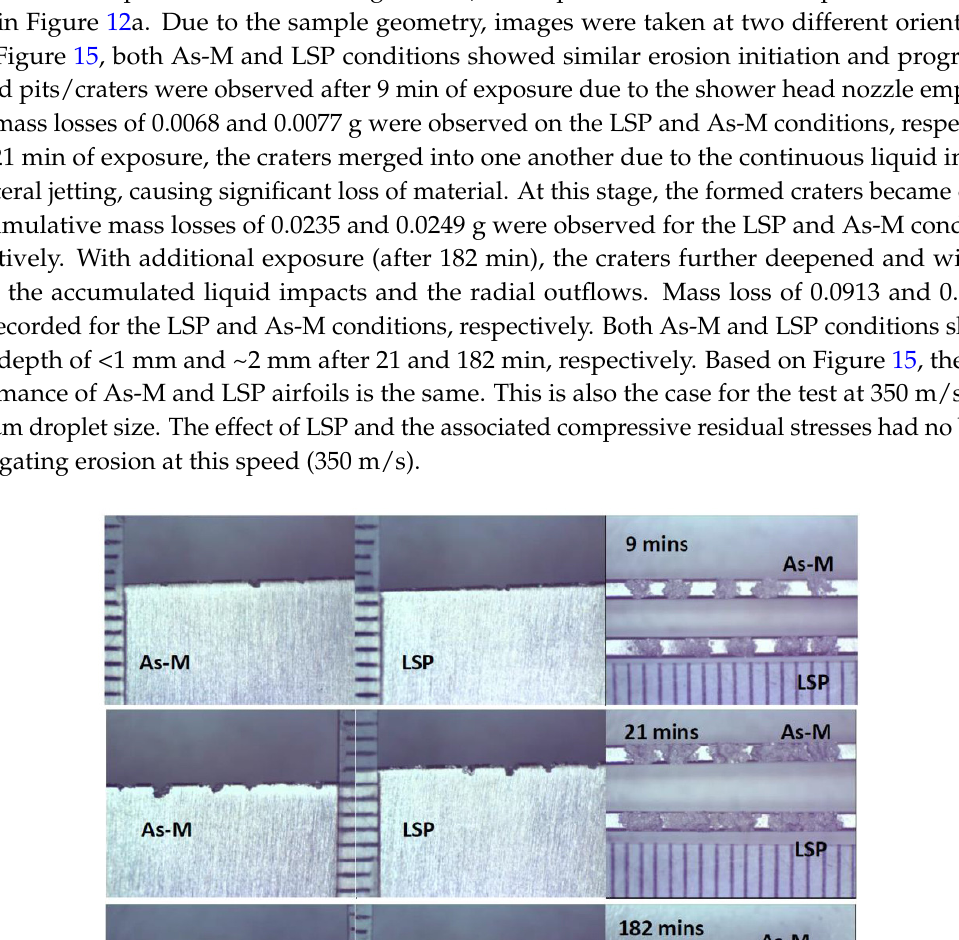
Figure 14. Optical macrographs showing the erosion evolution and progression on As ‐ M and LSP samples tested at ( a ) 250 m/s and ( b ) 300 m/s.